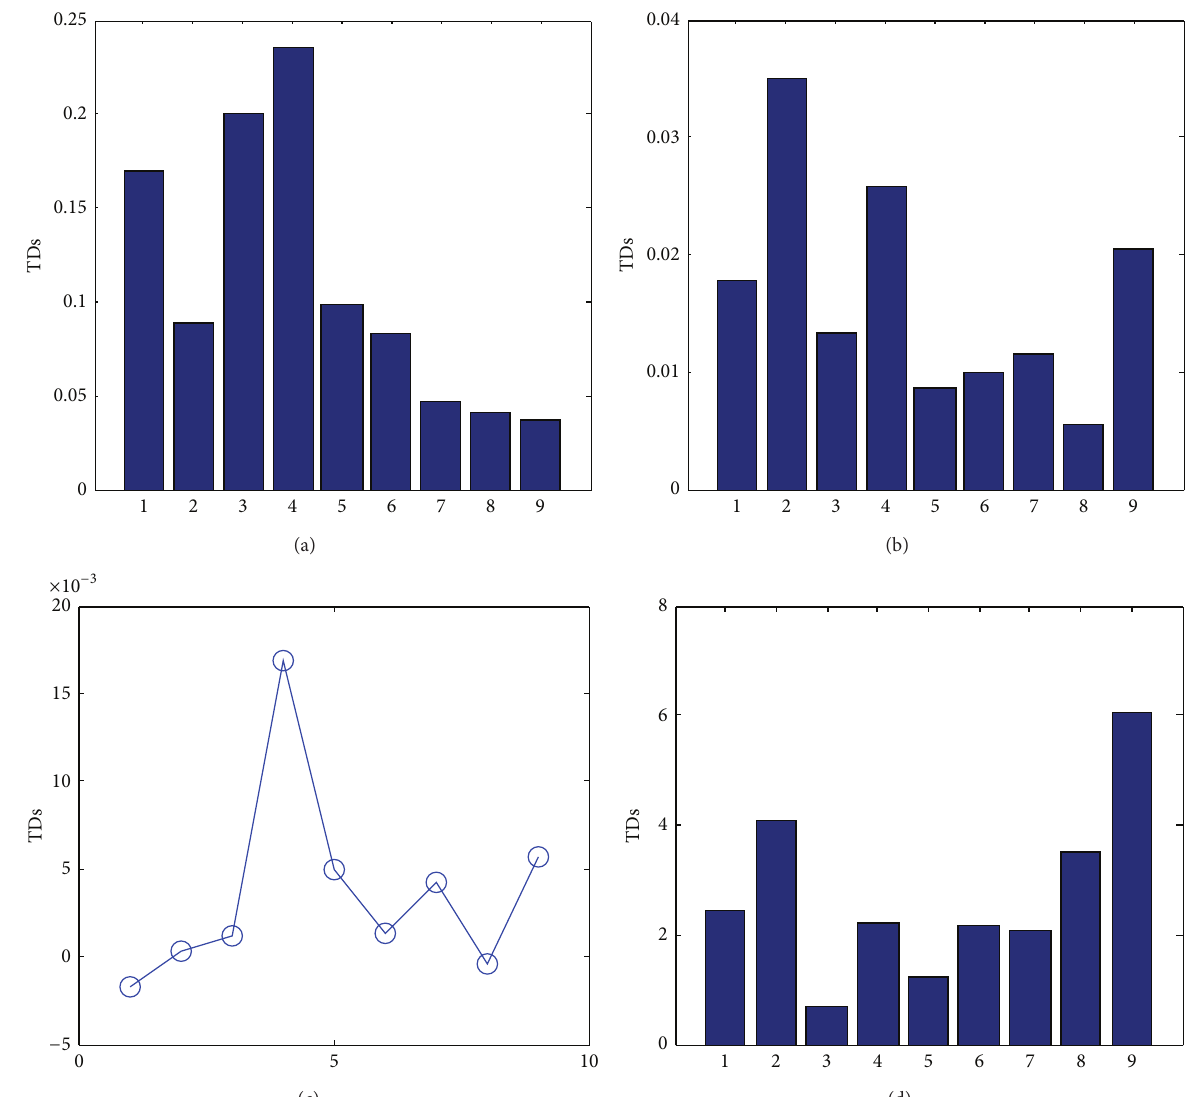
Figure 14: Detection indicators of the cantilever beam when 𝛾 = 0 . 2 for frequency band of 0–50 Hz with 40dB: (a) this paper, (b) Schulz et al. [4], (c) magnitude value of Zhang et al. [6], and (d) Johnson and Adams [9].